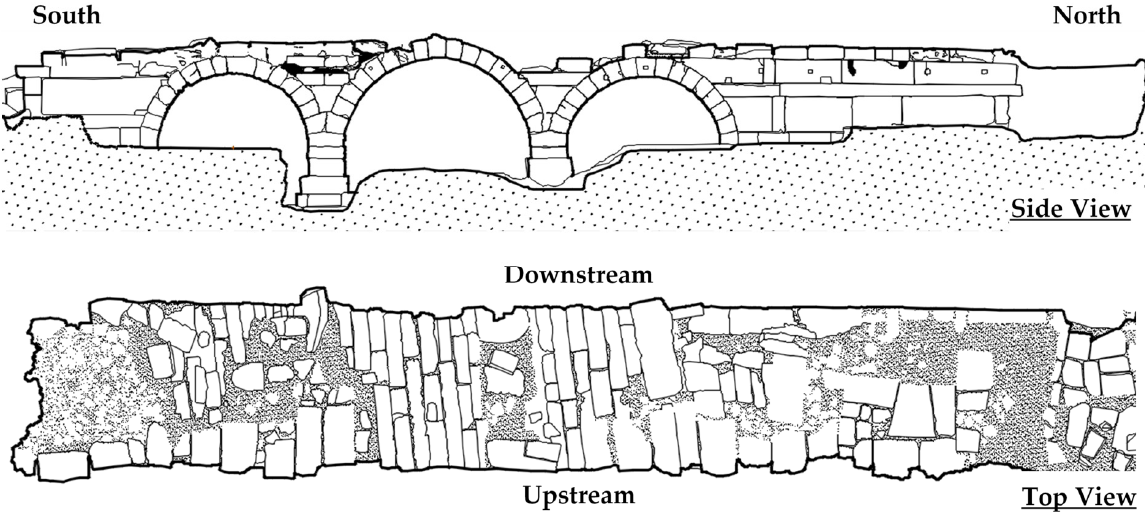
Figure 5. Survey drawings of the case study bridge (courtesy of ANB Architecture).